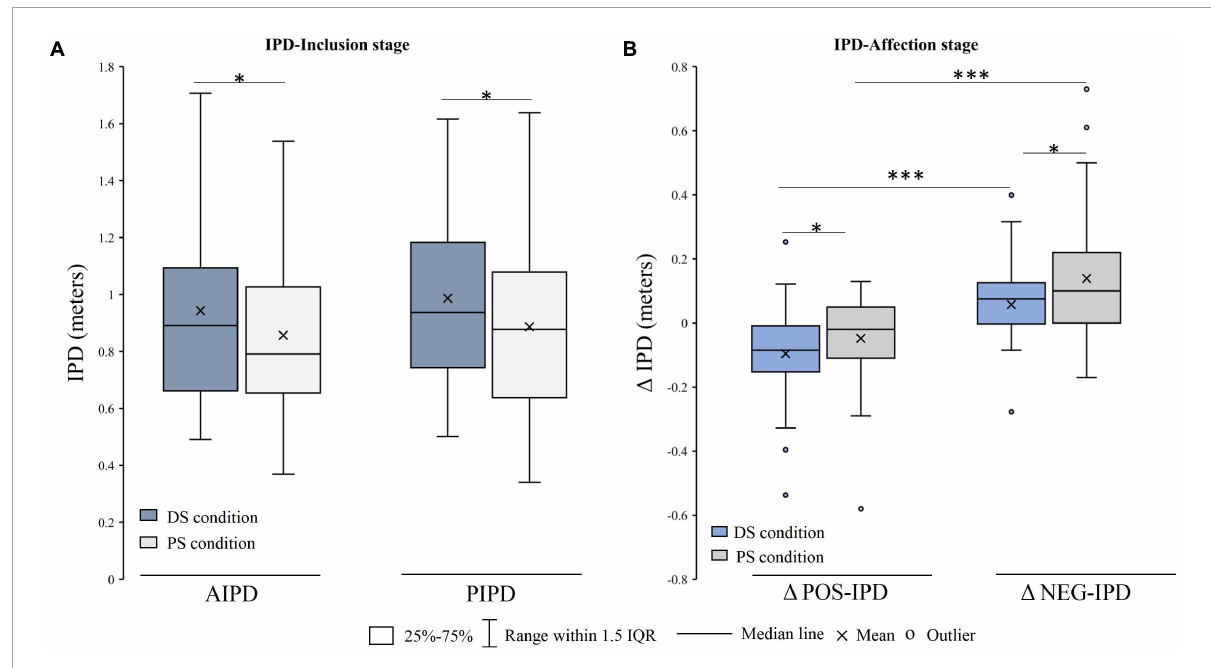
FIGURE4 Interpersonal distance (IPD) difference between DS condition and PS condition. (A) IPD difference in the IPD-Inclusion stage. (B) (cid:49) IPD difference in the IPD-affection stage. DS, differing social status; PS, peer social status; AIPD, active interpersonal distance; PIPD, passive interpersonal distance; (cid:49) POS-IPD/NEG-IPD, the IPD after positive/negative IPD feedbacks minus the baseline; IQR, interquartile range; ∗ p < 0.05; ∗∗∗ p <